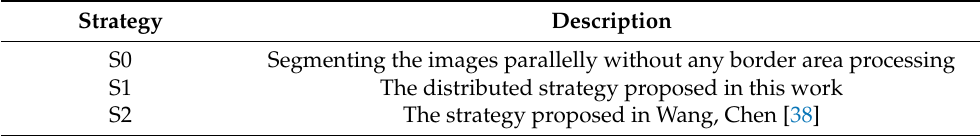
Table 2. Strategies used for comparison and the simple